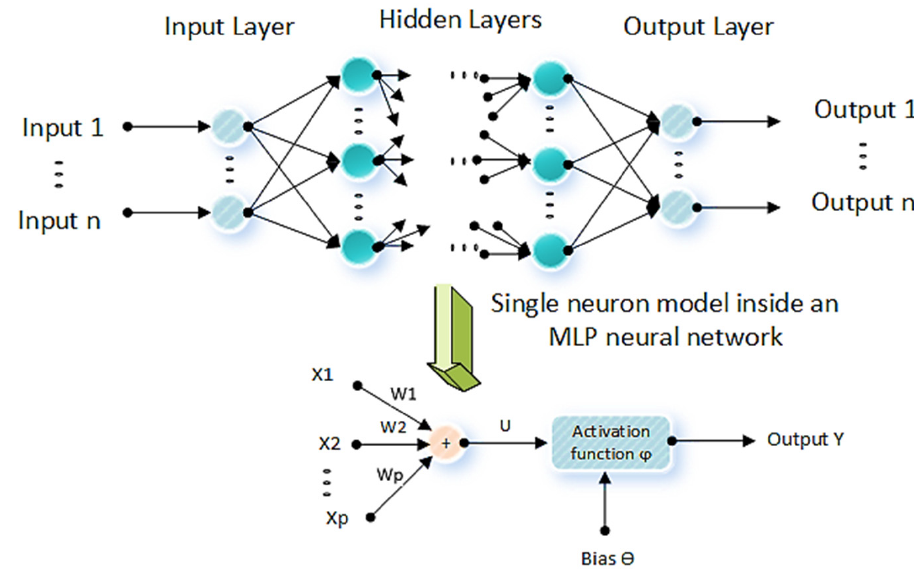
Figure 3. Structure of an MLP neuron network.